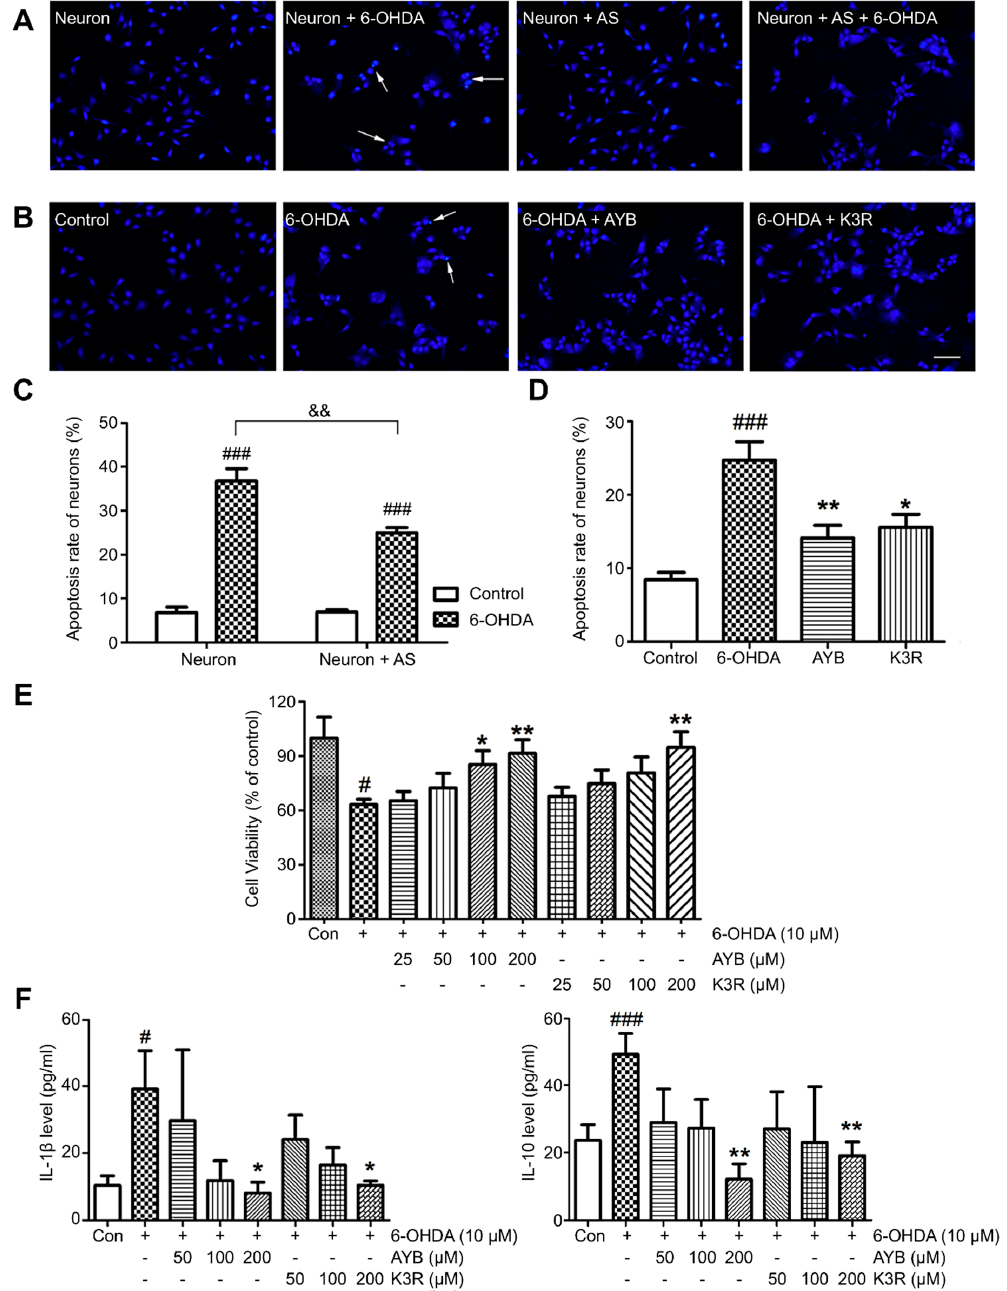
Figure 4. Effect of K3R and AYB in a neuron-astrocyte coculture system. ( A – C ) The coculture (neuron + astrocyte (AS)) system reduced apoptosis rate of neurons as compared with single-culture (neuron). Representative photographs of nuclear bodies stained with Hoechst 33342, apoptotic cell nuclei were indicated by the arrows; ( B – D ), Effect of K3R and SYB on the neuronal apoptosis rate in the coculture system (bar = 50 μ m); ( E ) Effects of K3R and AYB on the neuronal viability in the coculture system damaged by 6-OHDA; ( F ) Contents of IL-1 β and IL-10 in the co-culture medium. n = 6. # p < 0.05, ### p < 0.001 vs. control group; * p < 0.05, ** p < 0.01 vs. 6-OHDA group; and && p < 0.01 6-OHDA group of co-culture vs. 6-OHDA group of single culture.